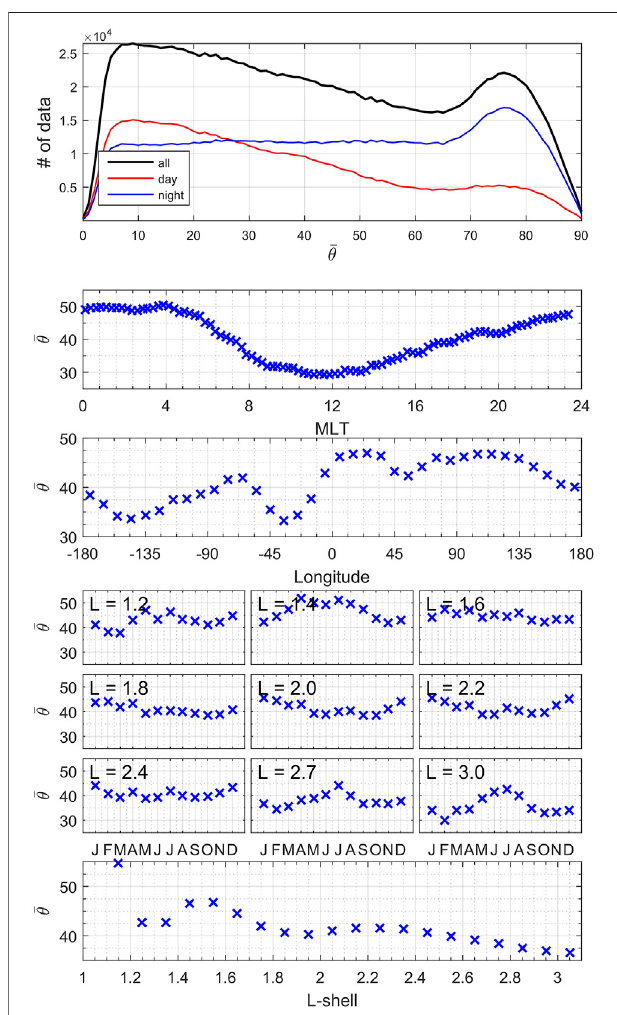
FIGURE 8 | ( fi rst panel) Distributions of the wave normal angle ( θ ) (in ° ) at (red) day (6 – 17 MLT), (blue) night (18 – 5 MLT), (black) all times. Wave normal angle is plotted versus (second panel) MLT and (third panel) longitude. The day/nightdifferencesappearclearlybutnotthecontinentaldependence. (fourth panel) Monthly and ( fi fth panel) total average of wave normal angle versus L-shell. No simple seasonal dependence is found.